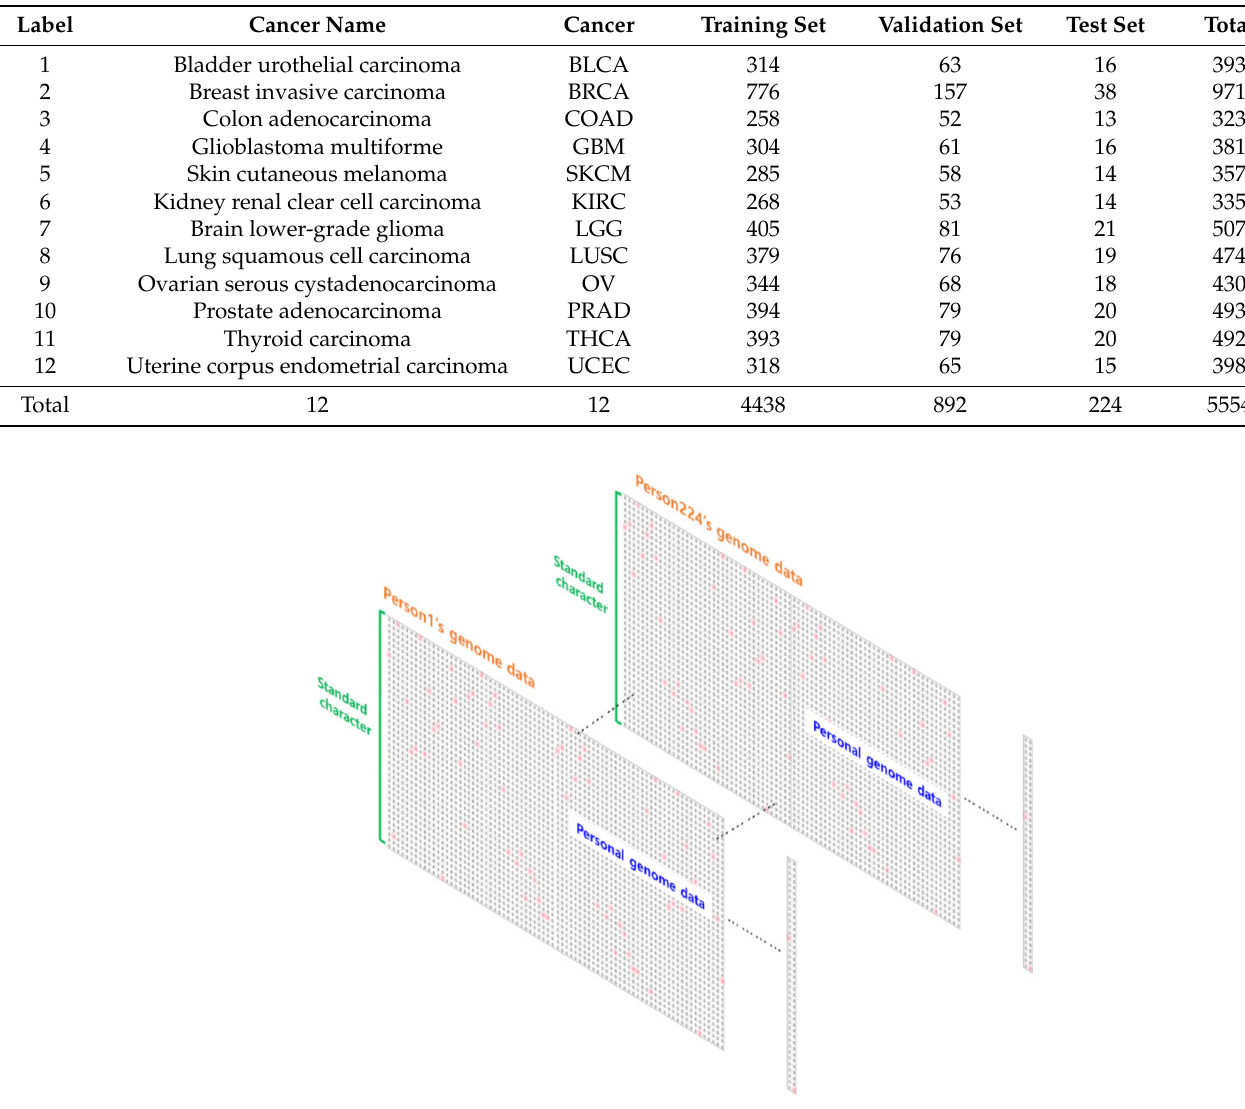
Figure 1. Example of a sample dataset used for